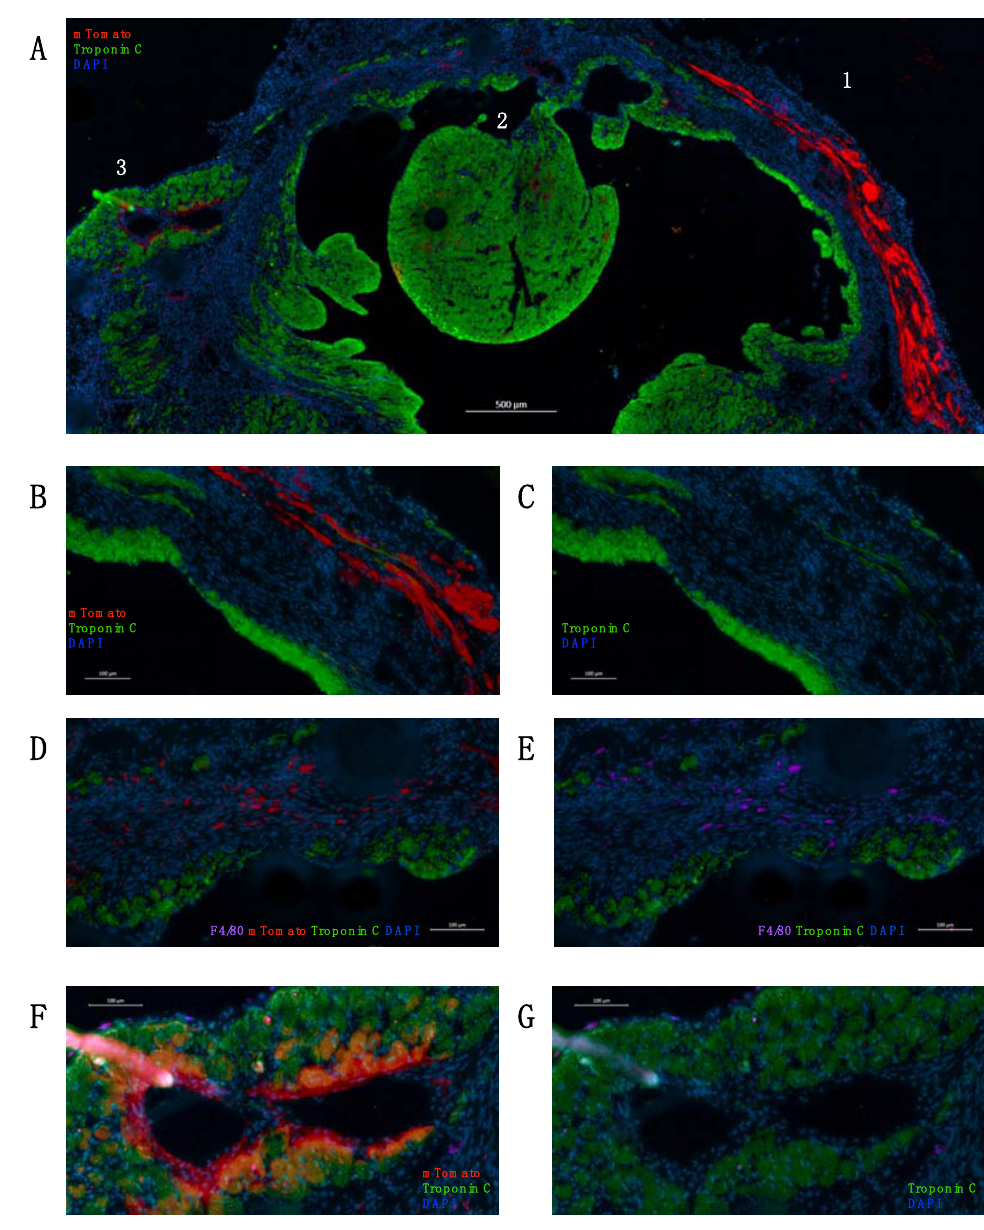
Figure 5. Tissue section analysis 8 weeks after the LAA transplantation. ( A ) Cross-sectional image from mitral valve level demonstrating a clear mTomato signal 8 weeks after operation. Troponin C = green, mTomato = red, and DAPI = blue. The following images are zoomed from frames 1, 2, and 3. ( B , C ) Frame 1: an image from LAA transplant zone demonstrating a strong mTomato signal, mostly in non ‐ troponin ‐ C ‐ stained tissue. ( D , E ) Frame 2: an image from the remote infarct area demonstrating mTomato+ migrated cells, which co ‐ express F4/80 (magenta). ( F , G ) Frame 3: an image from the remote infarct area demonstrating a strong mTomato signal in a vessel structure, together with some co ‐ stained troponin ‐ C ‐ positive cells.